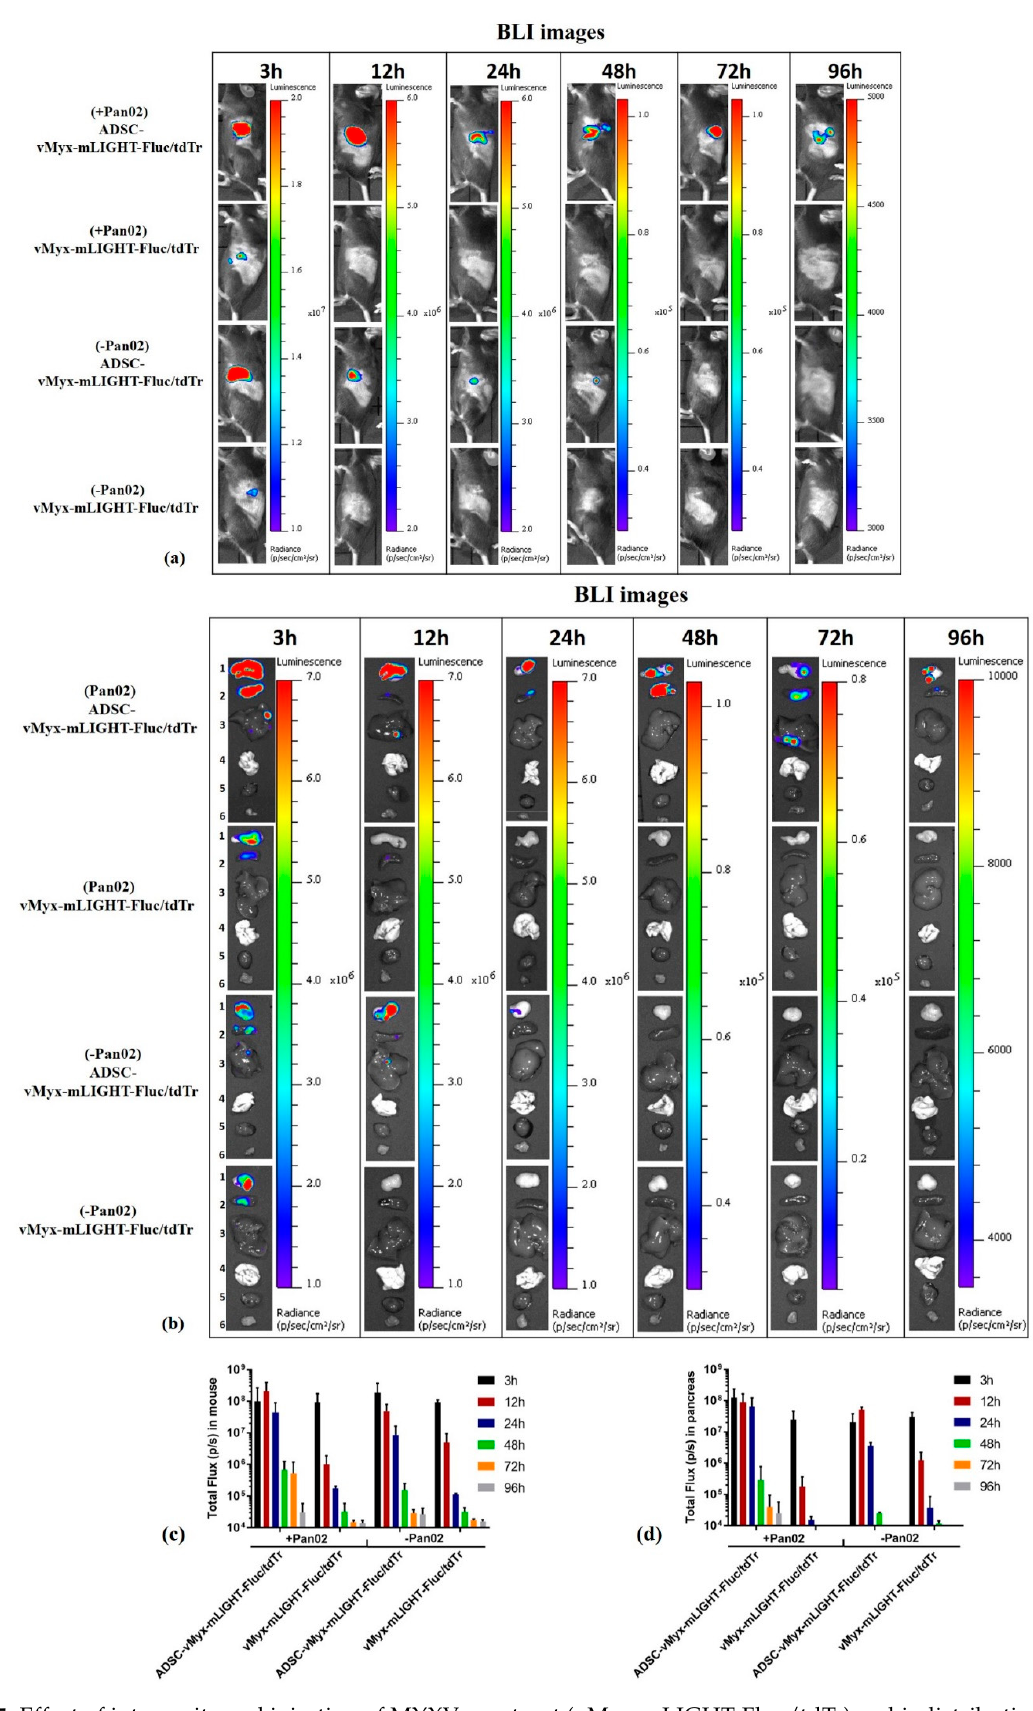
Figure 5. Effect of intraperitoneal injection of MYXV construct (vMyx-mLIGHT-Fluc/tdTr) on biodistribution in mice. Bioluminescence (BLI) images were acquired either in unchallenged ( − Pan02) mice injected IP with PBS − only, and